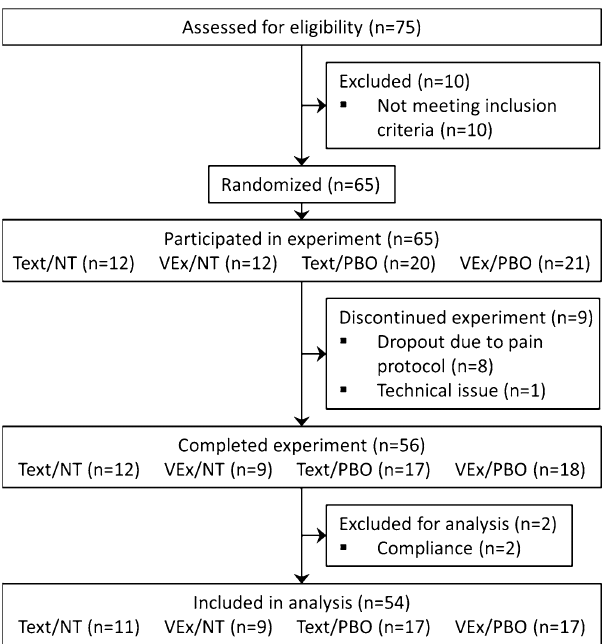
Figure 3. CONSORT statement for study enrollment. Attrition due to discontinued experiments was 14% (n = 9). Exclusions for compliance due to implausible core measures (pain ratings of zero) and antagonism (dozing off during baseline).